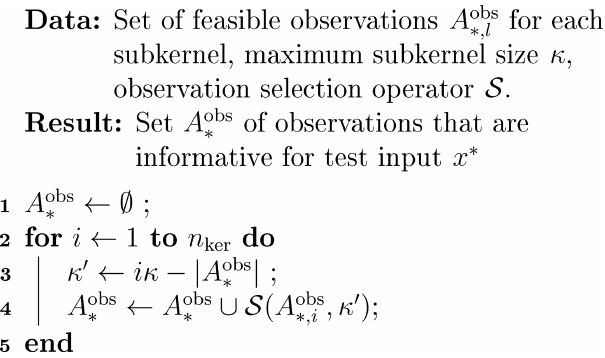
Figure 4. Algorithm for selecting observations for carrying out pre- dictions at test input x ∗ . The sets A obs ∗ are defined by Eq. (21), and the variable κ is the maximum subkernel size, also listed in Table 2 ,κ (cid:48) ) chooses and discussed in Sect. 3. The selection operator S (A obs ∗ ,l κ (cid:48) observations from each A obs ∗ either greedily or ,l